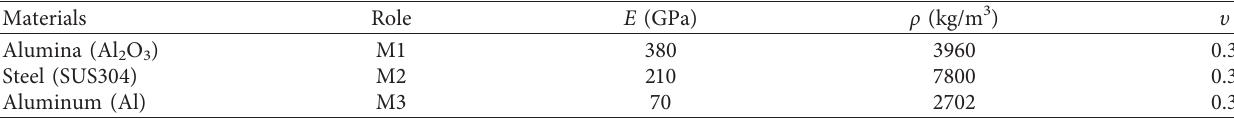
f and ρ f in the thickness and length directions. (a) E f with n x Table 1: Properties of constituent materials of BFGSW